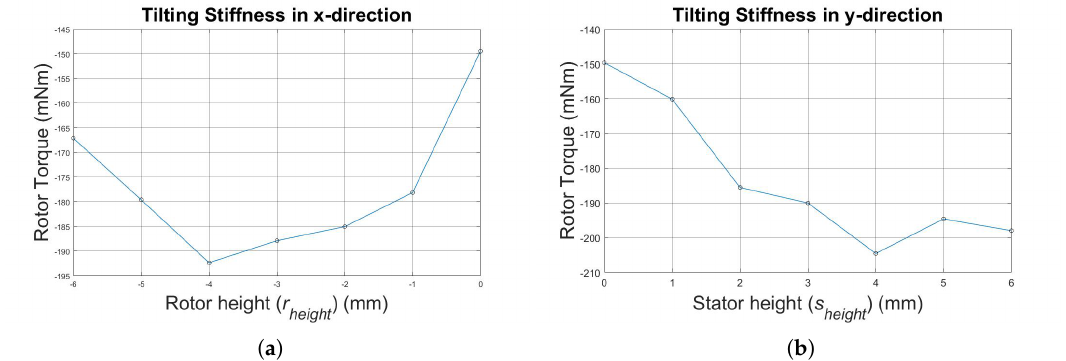
Figure 9. ( a ) Tilting stiffness in the x-direction with decreasing rotor height; ( b ) tilting stiffness in the y-direction with increasing stator